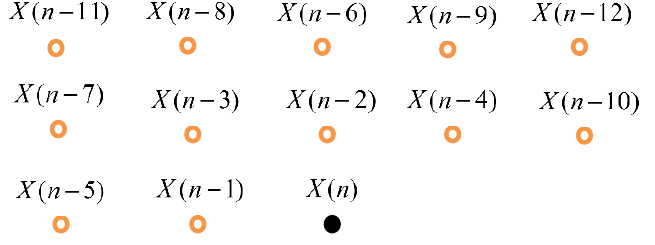
Figure 6. Ordering of the casual neighbors.